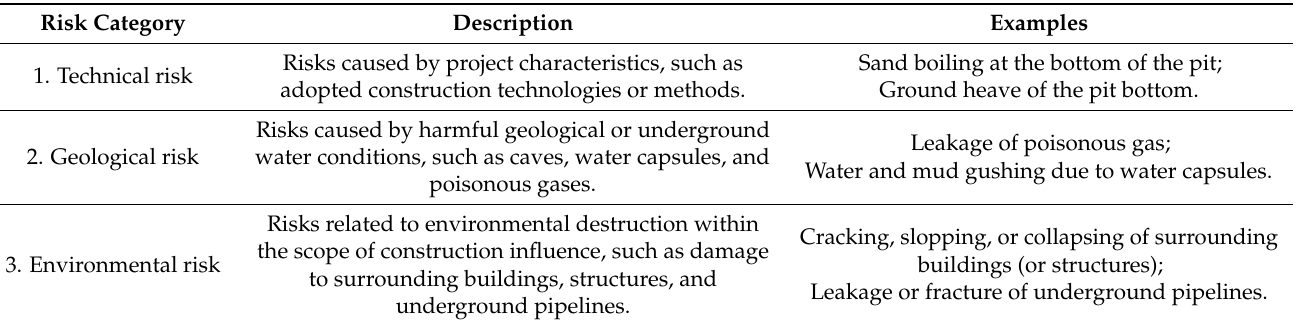
Table 1. Objective risk categories related to construction safety management of deep